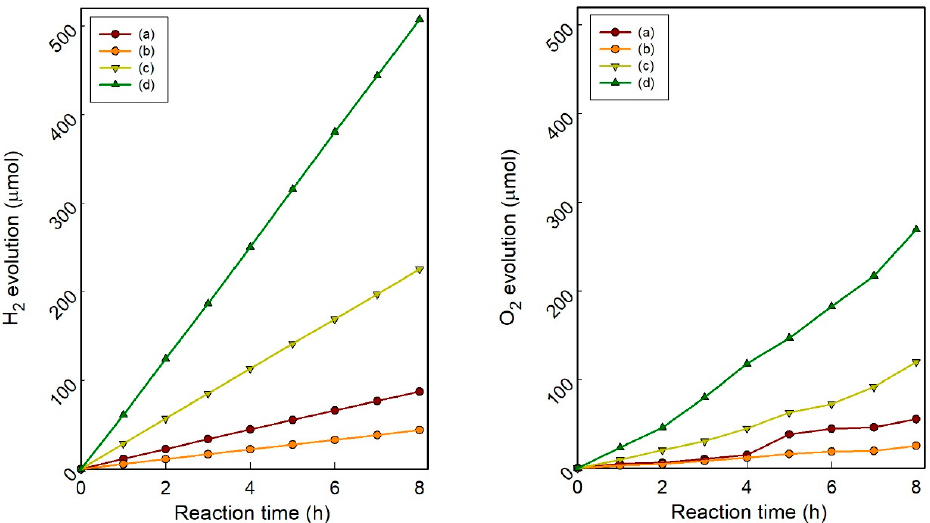
Fig. 8 FE-SEM image of BiVO 4.